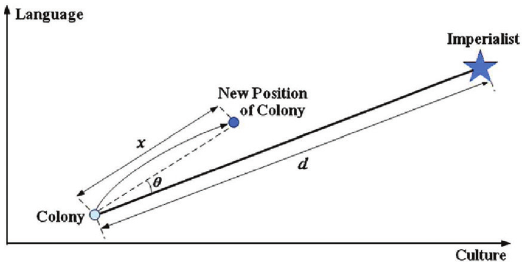
Figure 5. Moving colonies toward their relevant imperialist in a randomly deviated